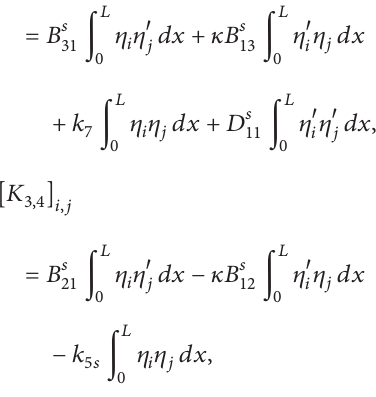
= −𝐵 𝑐 1,5 = −𝜅𝐵 𝑠 = −𝜅𝐵 𝑠